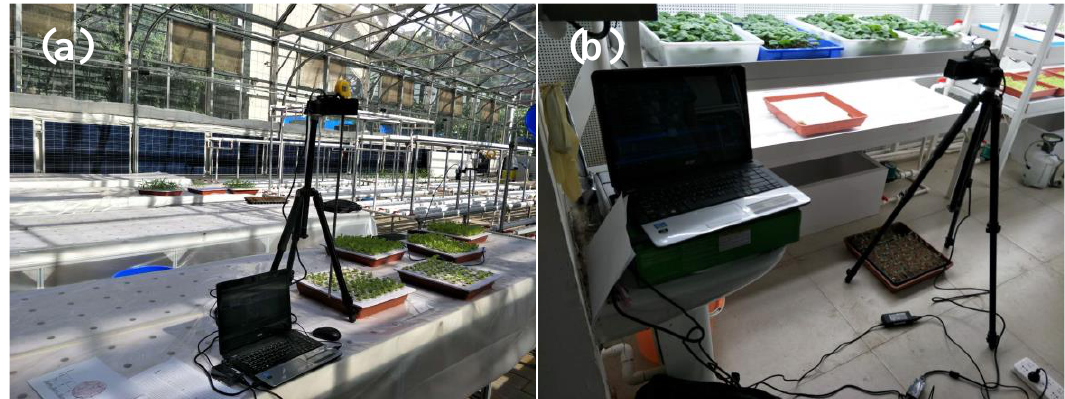
Figure 2. Vegetable seedling growing environments and data capturing setting: ( a ) experiment platform in the greenhouse; ( b ) experiment platform in the plant factory.